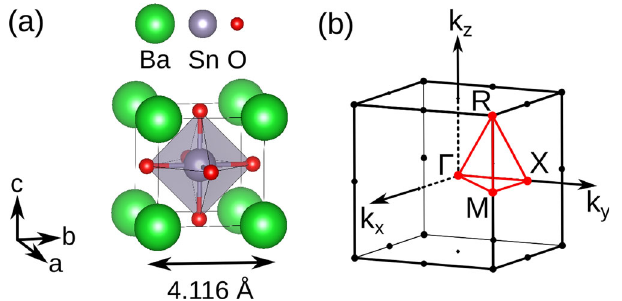
Fig. 1 Crystal structure of cubic BaSnO 3 . Primitive cell ( a ) and fi rst Brillouin zone ( b ) with high-symmetry points and paths (red) as used in Fig. 2.